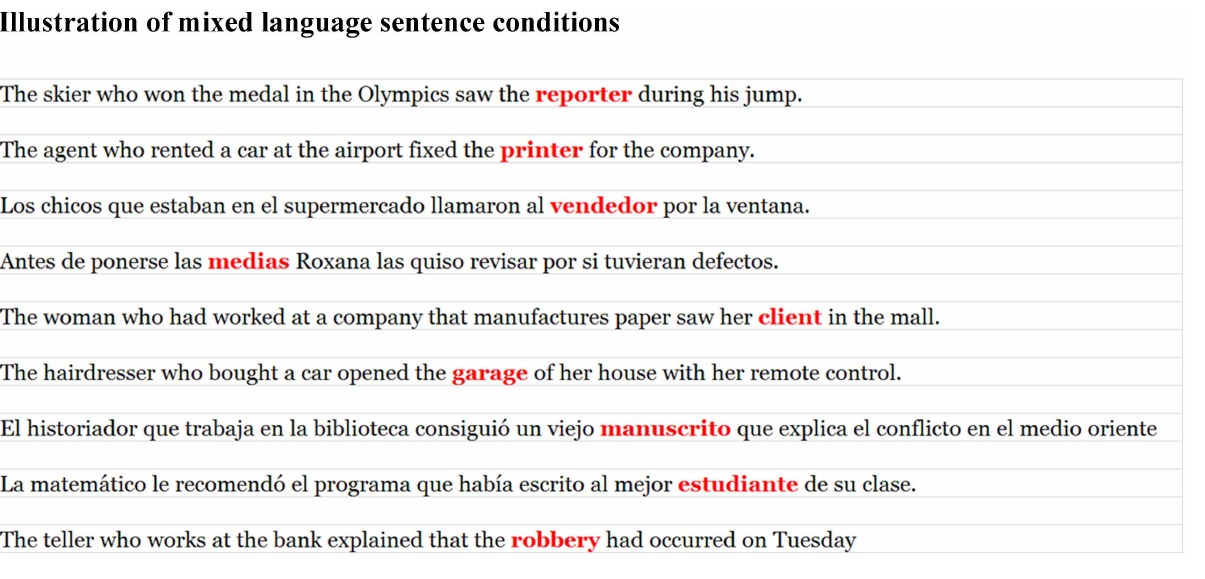
FIGURE 1 | Sentences were presented one word at a time using Rapid SerialVisual Presentation .The duration of each non-target word was 300ms. Target words were marked in red (targets are also bold here) and remained on the screen until they were spoken by the participant.